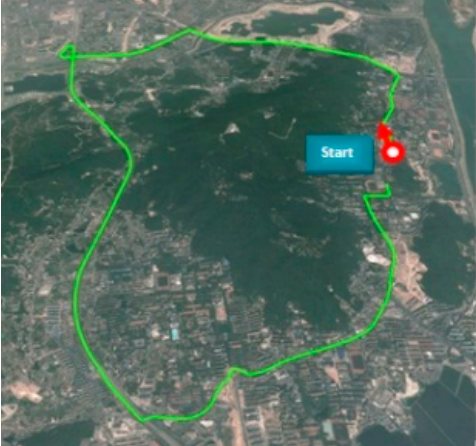
Figure 3. Test site and path (original photo from Google Map).